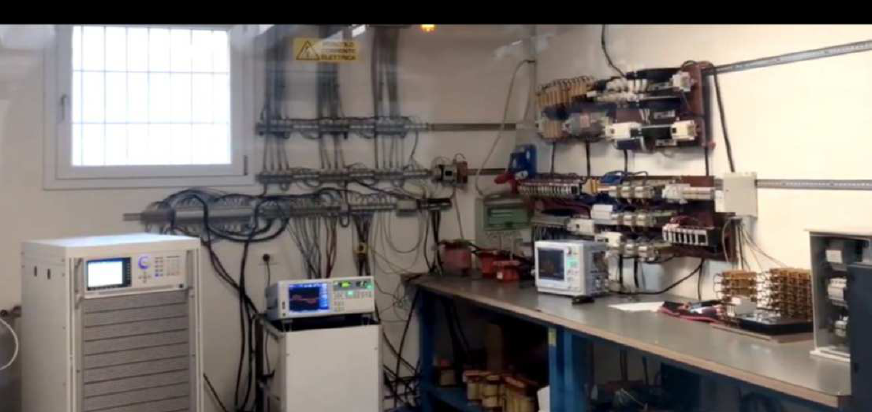
Figure 8. Experimental setup for power quality disturbances